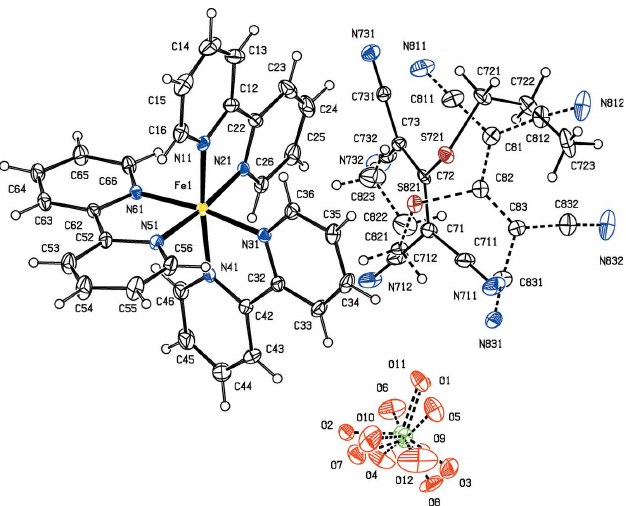
Figure 2 The independent ionic components in compound (II), showing the atom- labelling scheme. Displacement ellipsoids are drawn at the 30% probability level.